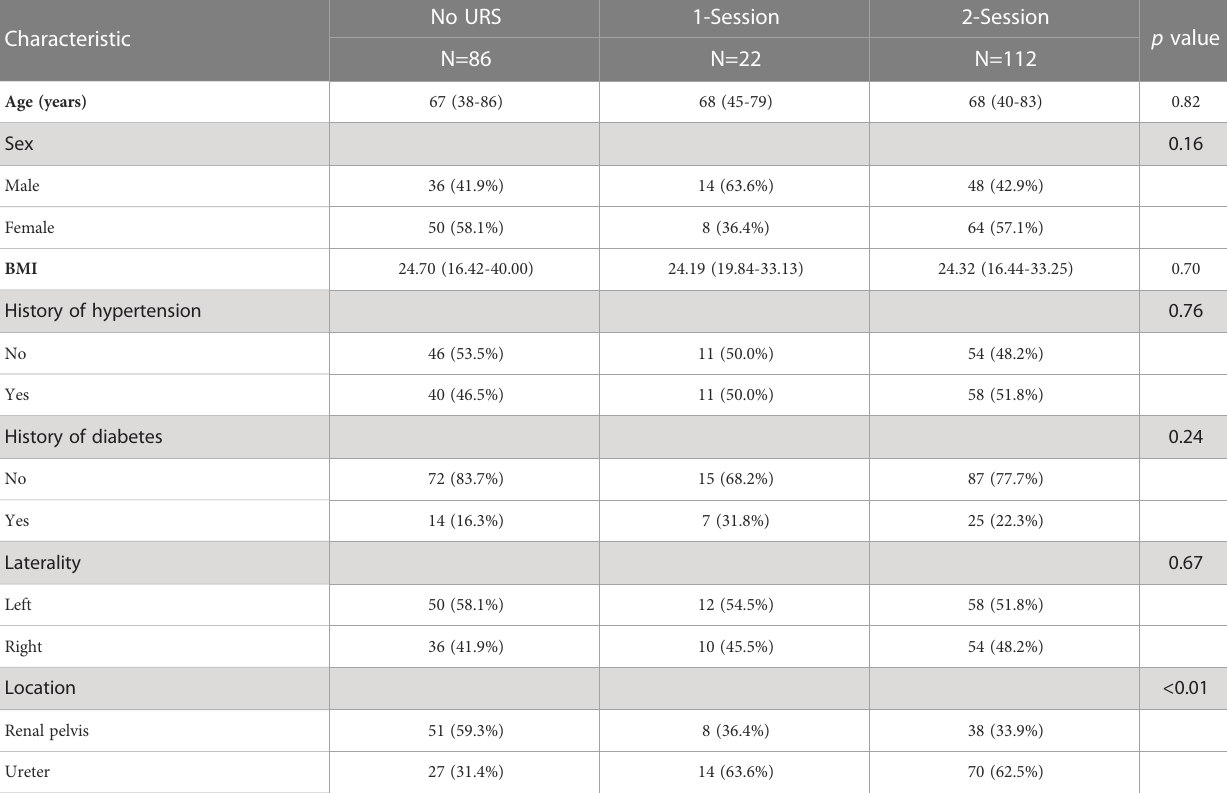
TABLE 1 Association between clinicopathologic features and preoperative URS in UTUC.